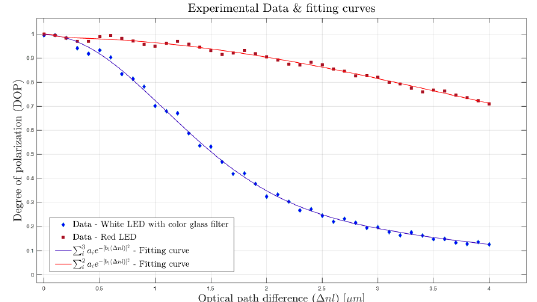
Figure 2. Graphic of the experimental